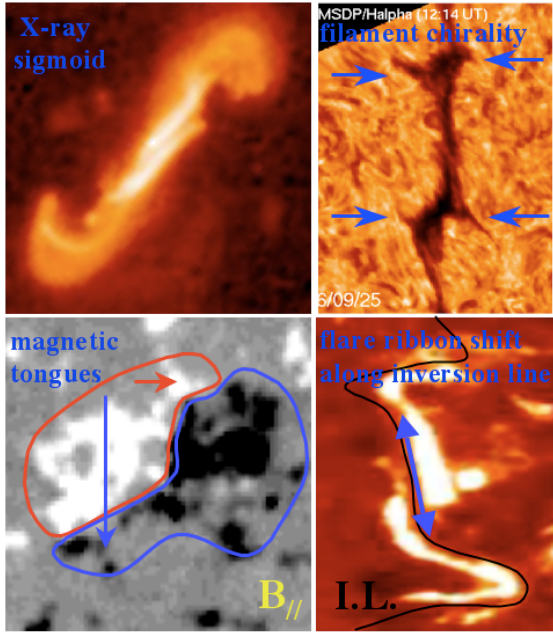
Fig. 16. Some characteristic patterns indicating a positive magnetic helicity (for negative helicity the images have to be mirrored). Soft X-ray sigmoids are the coronal trace of twisted or highly sheared field lines (Manoharan et al., 1996; Canfield et al., 1999). The global organization of fibrils and feet/barbs, i.e. their inclination on the filament axis, is another trace of a twisted/sheared magnetic field (Martin et al., 1994; Aulanier et al., 1998). The spatial distribution of the vertical magnetic field component in emerging active regions is often asymmetric, with lateral extensions to the main bipolar po- larities. These “magnetic tongues” are the photospheric trace of the emerging sub-photospheric flux rope (L´opez Fuentes et al., 2000). Finally in a sheared field, the flare ribbon locations are separated along the inversion line. In some cases, they also have a character- istic J-shape if the twist is of the order or above one turn (D´emoulin et al., 1996).